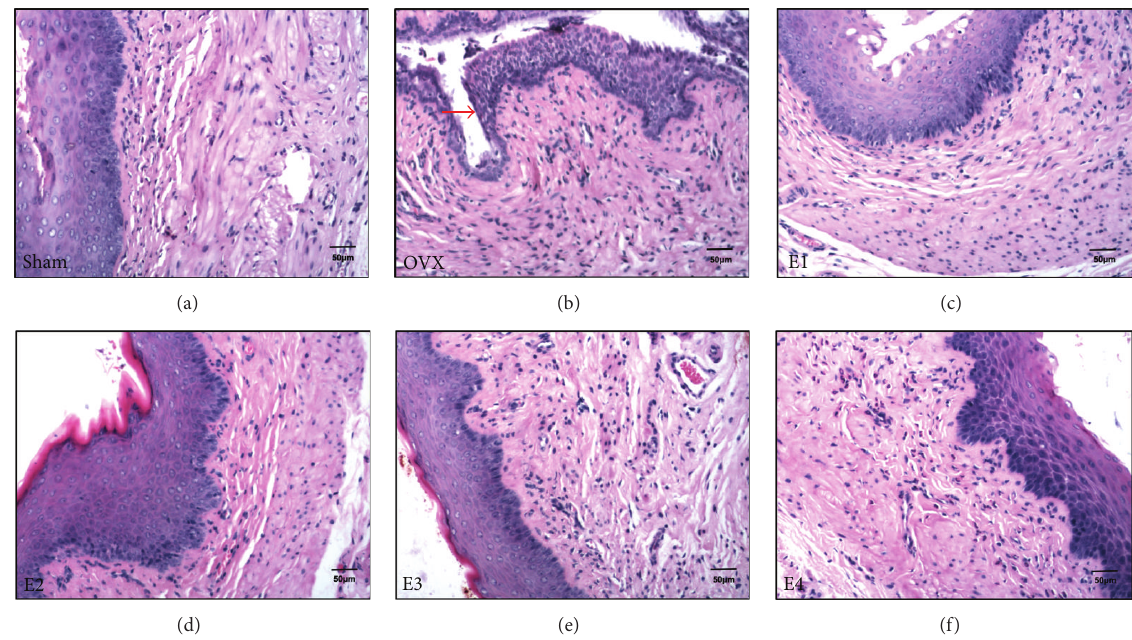
Figure 1: H&E immunostaining of vaginal tissue sections. (a)–(f) show H&E immunostaining of vaginal tissue sections from sham, OVX, E1, E2, E3, and E4 groups, respectively. The atrophic vaginal squamous epithelium in the OVX group is indicated by a red arrow in (b), exhibiting reduced epithelial stratification and cornification. Scale bar represents 50 𝜇 m (200x magnification). H&E, hematoxylin & eosin.